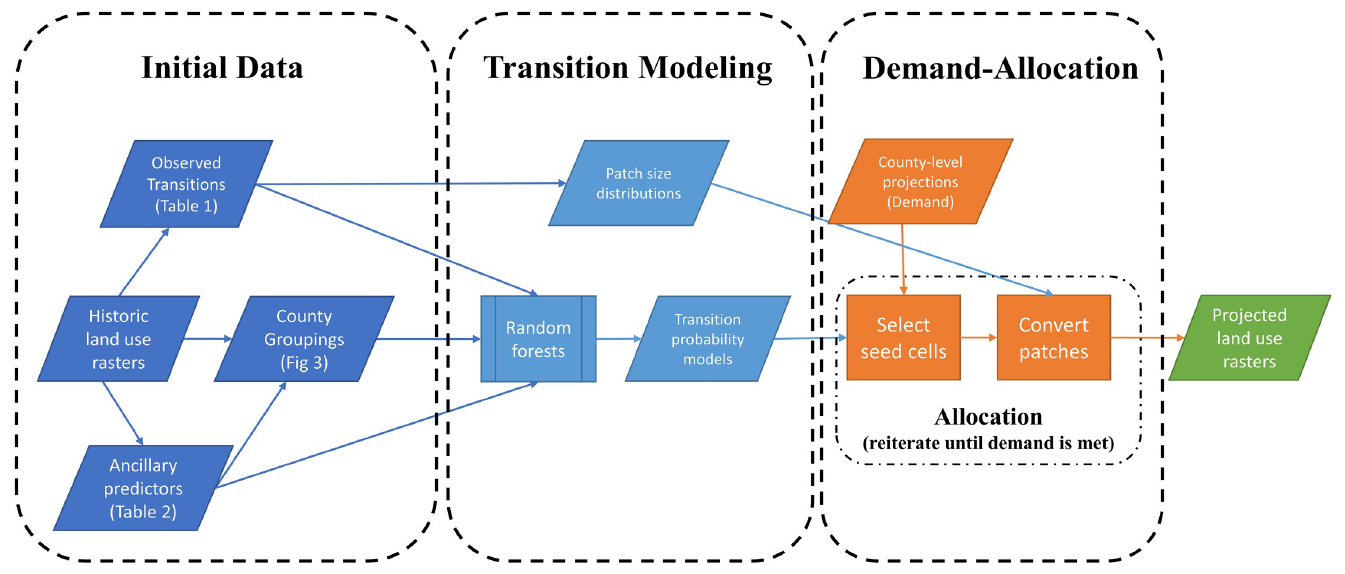
Fig 1. Methodology framework. Key components of the demand-allocation algorithm presented in this study.